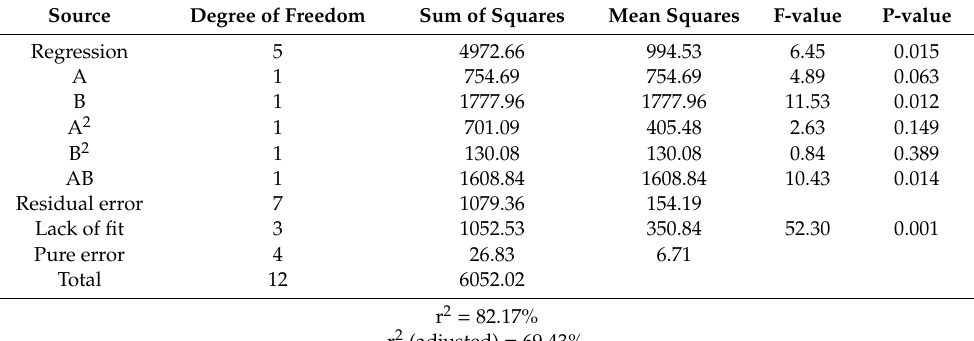
Table 4. ANOVA analysis of the model for the removal of RhB using the produced